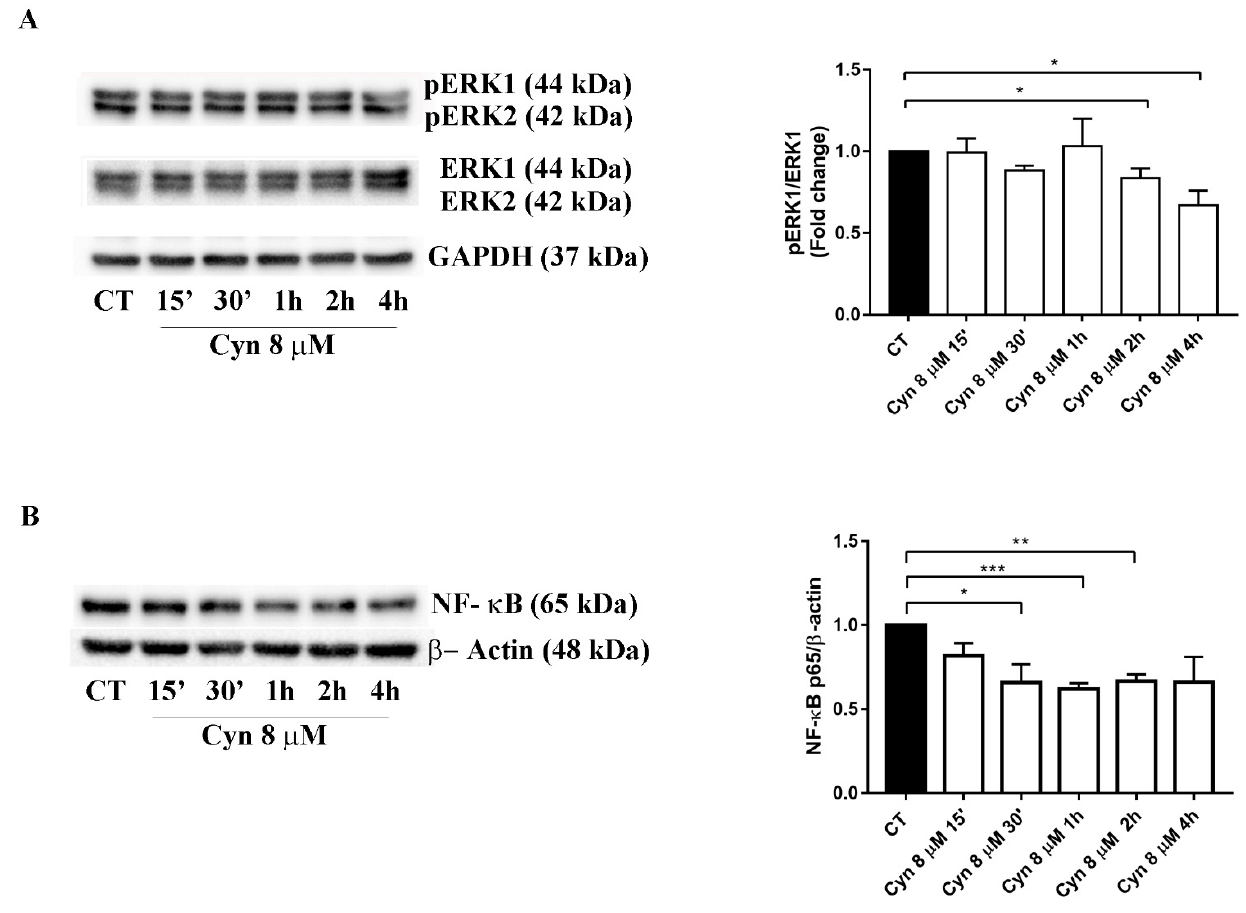
Figure 6. Effects of Cyn on ERK1/2 dephosphorylation and NF- κ B protein expression in U-87 MG cells treated with Cyn 8 µM. ( A ) Western blot analysis of proliferative signals pERK/ERK in short-term U87Mg cells treated with Cyn 8 µM. A densitometric analysis of the protein levels represent the means ± SEM of 3 individual determinations and are expressed as the fold change over control-treated cells. * Unpaired t -test, p -value < 0.05. According to GraphPad Prism, * p -values 0.01–0.05 (significant). ( B ) Western blot analysis of the NF- κ B p65 subunit in short-term U87Mg cells treated with Cyn 8 µM. A densitometric analysis of the protein levels represents the means ± SEM of 3 individual determinations. Data are expressed as the fold change over control-treated cells normalized to the housekeeping gene β -actin. * Unpaired t -test, p -value < 0.05. According to GraphPad Prism, * p -values 0.01–0.05 (significant), ** p -values 0.001–0.01 (very significant) and *** p -values 0.0001–0.001 (extremely significant).